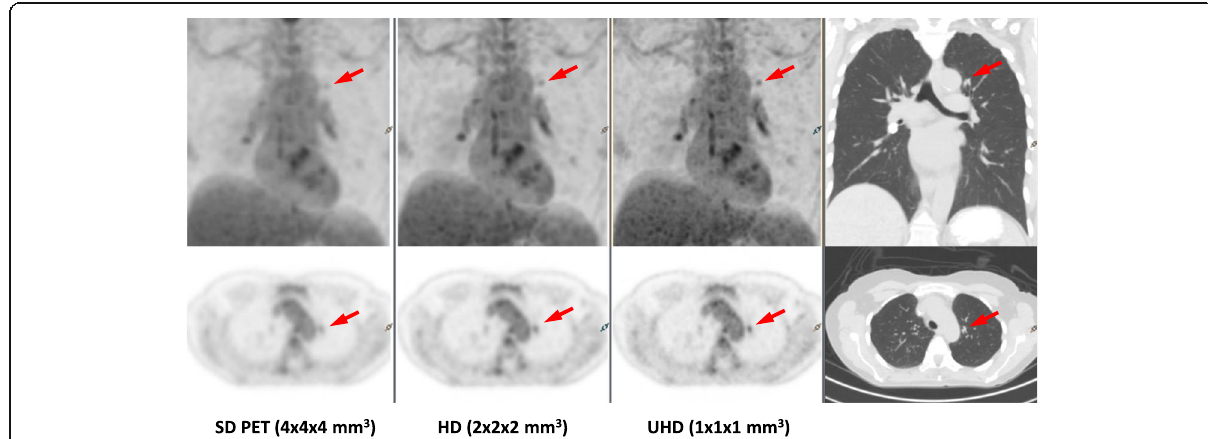
Fig. 10 Anal cancer patient scanned on the dPET system (BMI = 24, 481 MBq FDG, 50 min uptake time) and reconstructed in SD, HD, and UHD using 3D OSEM TOF algorithm, in contrast with CT image on the right. The small lesion (red arrows) becomes more visible from SD PET to UHD PET with less PVE noted in the smaller isotropic voxel images